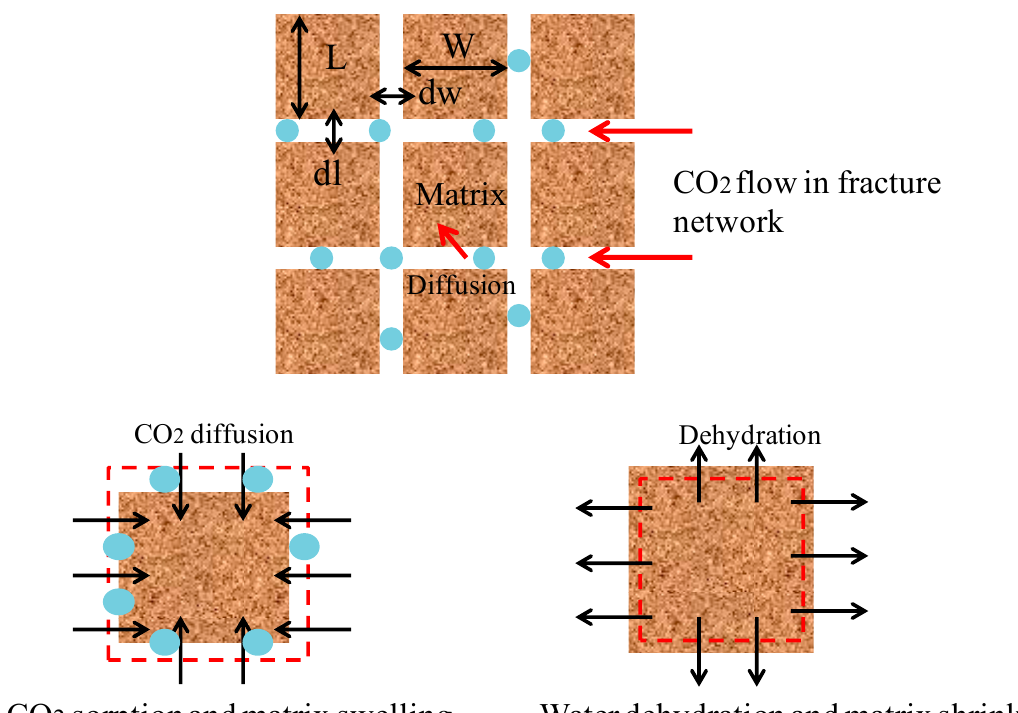
Figure 2. CO 2 sorption and dehydration model in shale caprock. The abbreviated letters L, dl, W, and dw are short for length, derivative of length, width, and derivative of width, respectively.